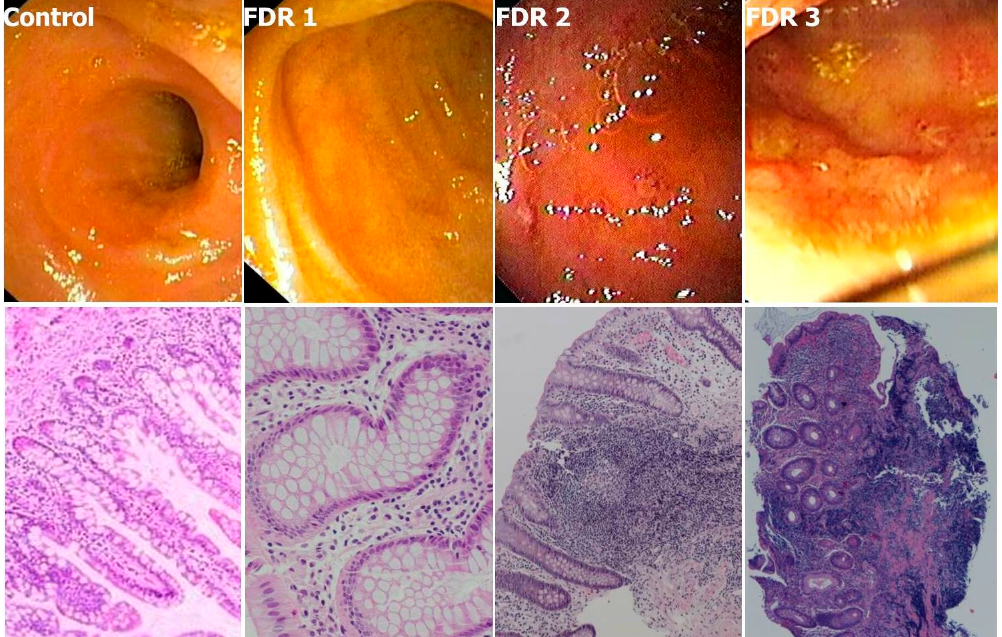
Figure 1. The three FDR phenotypes compared to controls in the colonoscopy based screening study. FDR1: normal—identical to controls; FDR2: with tiny aphthae or superficial erosions; and FDR3: with frank but limited and very early CD inflammation and ulcers. Corresponding phenotypes at histology were for FDR1: normal; for FDR2: mild inflammatory lesions including crypt reduction, chronic inflammatory infiltrate, lymphoid hyperplasia and superficial erosions; and for FDR3: histological features typical of CD with more severe inflammation, crypt distortion, focal fibrosis of muscularis mucosae, and superficial ulcerations (H&E, 10 × except FDR1: 20 × ). Reprinted with permission [26].